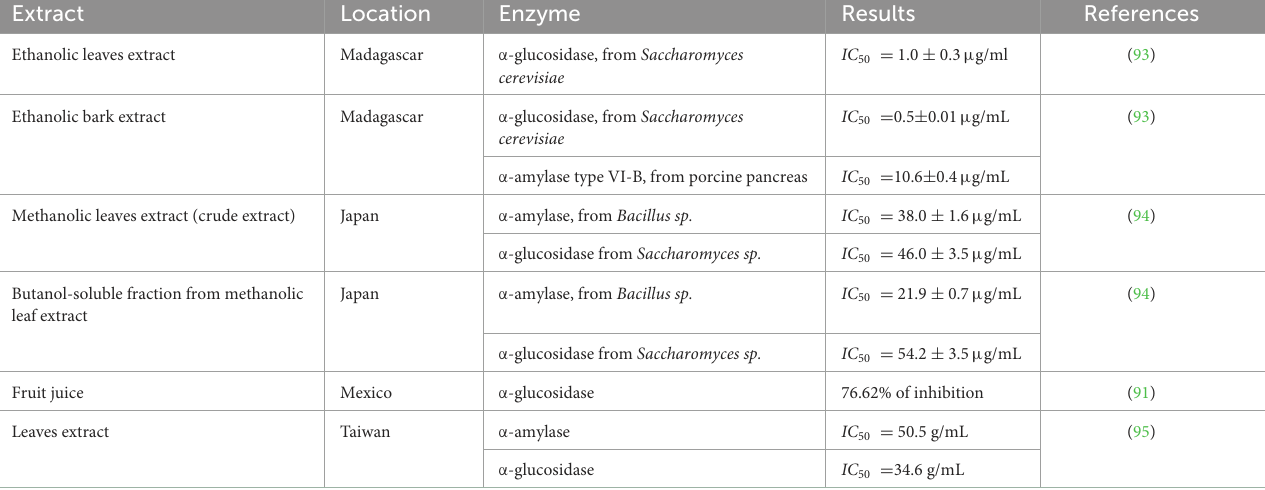
TABLE 5 Inhibition of α -amylase and α -glucosidase by Psidium guajava L. extracts.